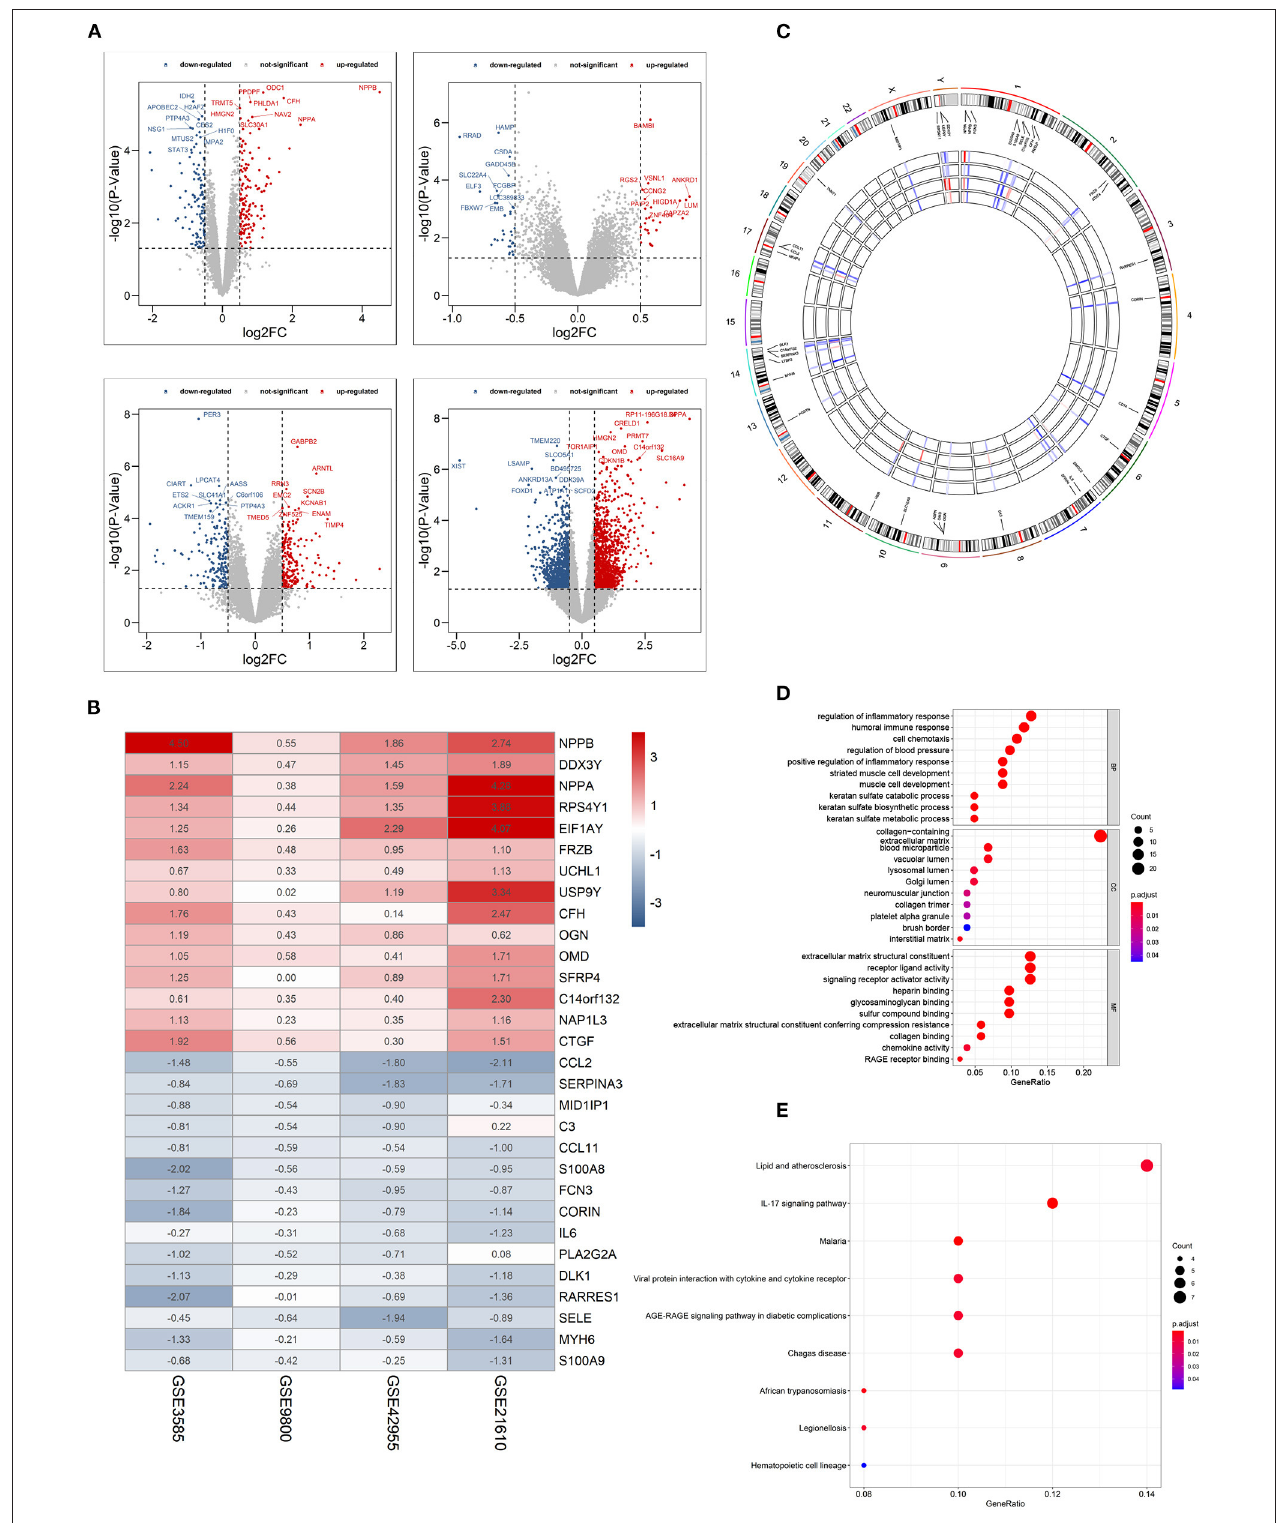
FIGURE 2 | Identification of differentially expressed genes (DEGs) between dilated cardiomyopathy cardiac and normal cardiac tissues samples from four unrelated cohorts. (A) Volcano plots of datasets GSE3585 and GSE9800 (upper panel), and GSE21610 and GSE42955 (lower panel) from the GEO database. DEGs